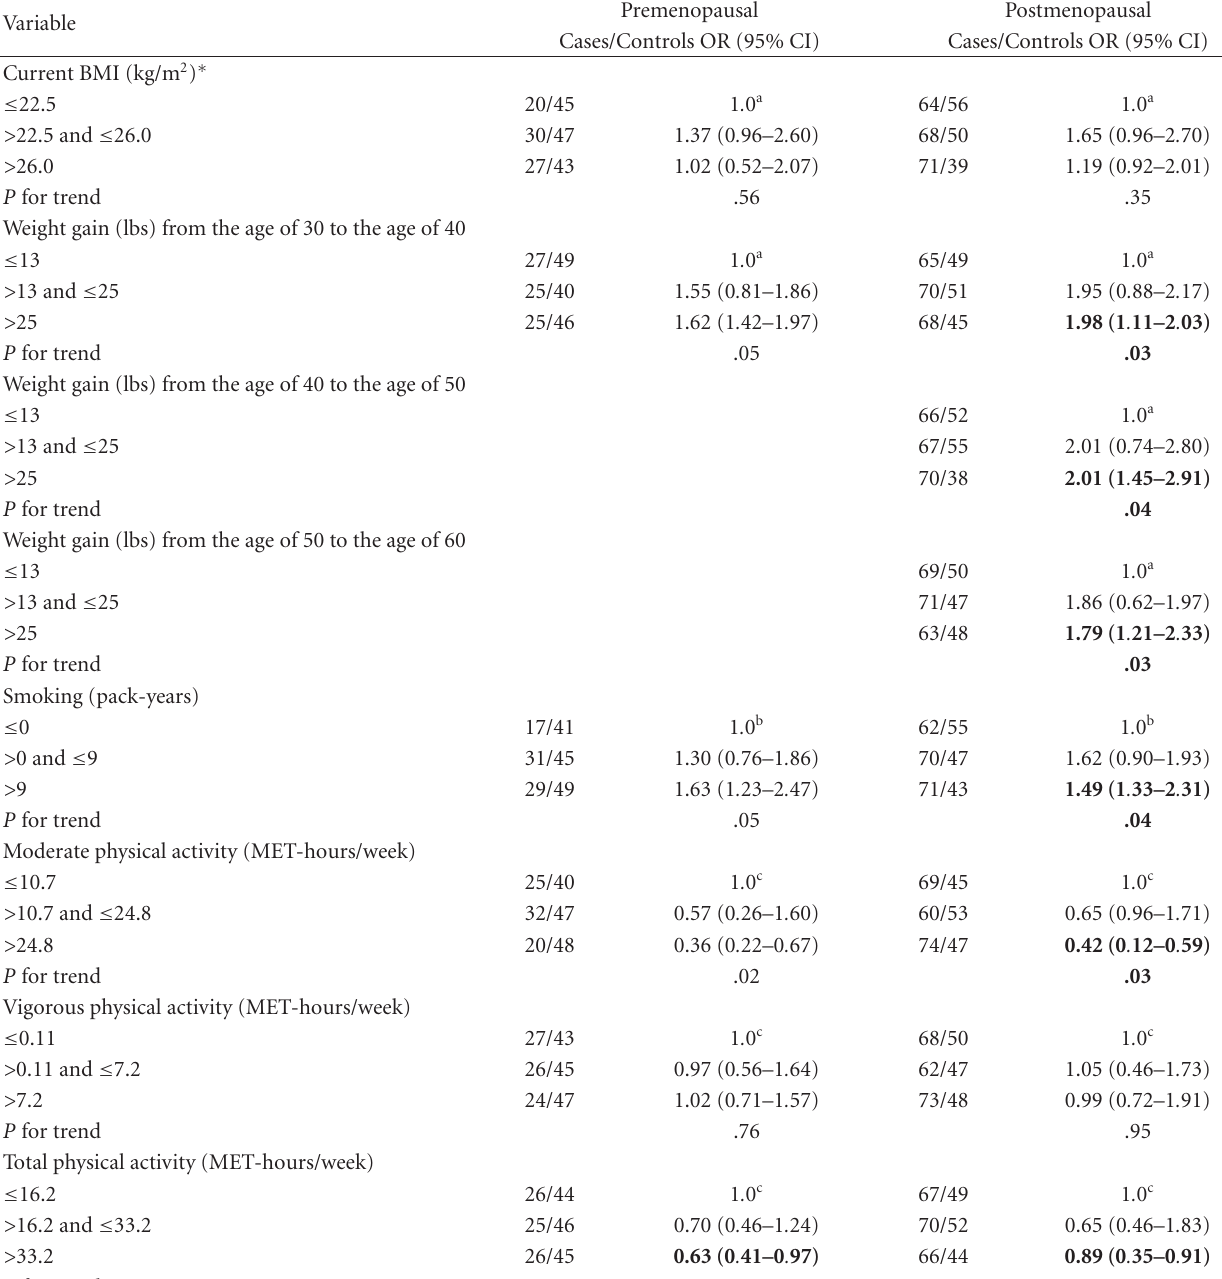
Table 4: Multivariable adjusted odd ratios and 95% confidence intervals for breast cancer risk in relation to BMI, weight gain, smoking, and physical activity, by menopausal